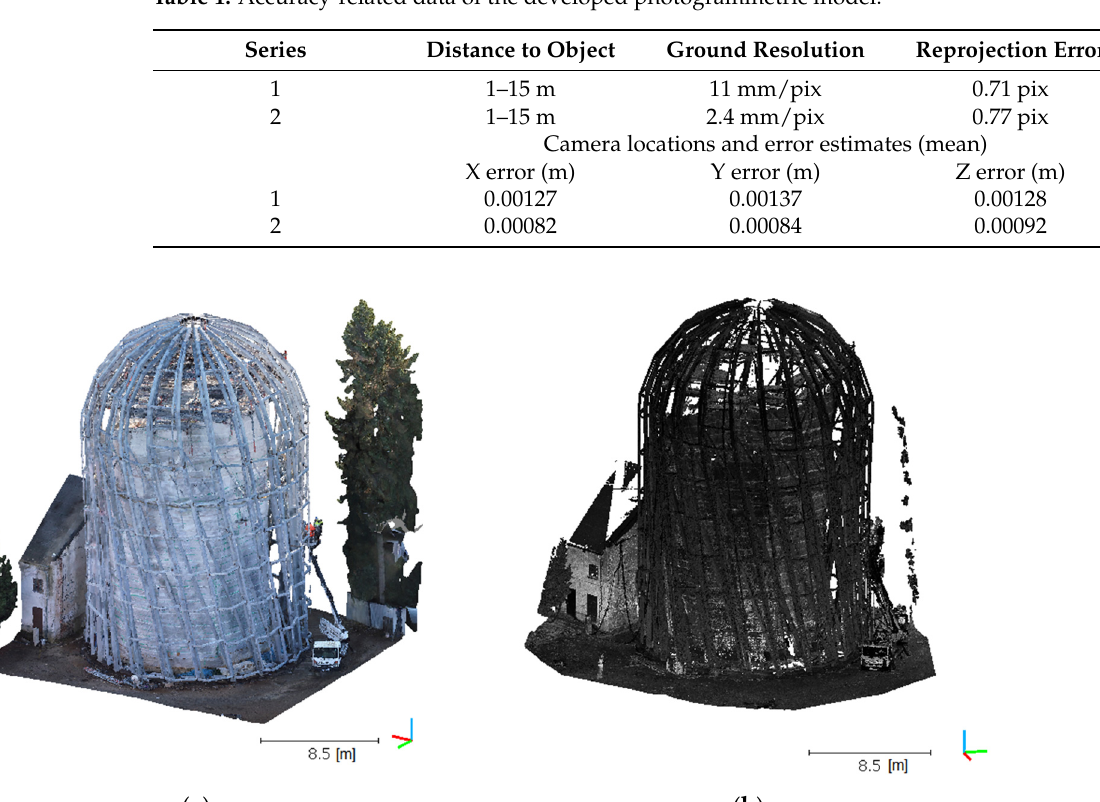
Table 1. Accuracy-related data of the developed photogrammetric model.